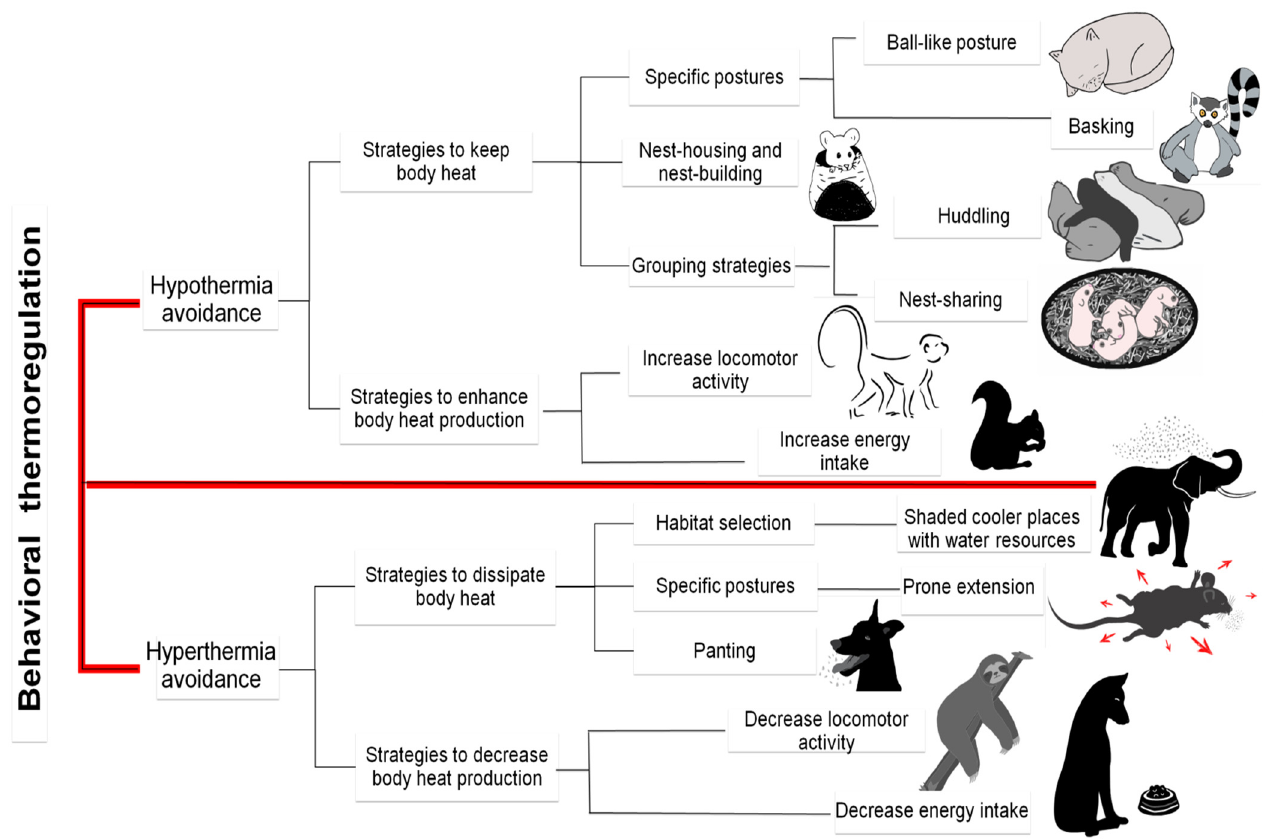
Figure 10. Behavior strategies used to control body heat. These are divided into those performed to prevent (i) hypothermia and (ii) hyperthermia. It is important to note that such factors as the time of day, season, gender, and age, can affect these thermoregulatory adjustments [7]. (Exclusive images created by Lupita Mota R.).